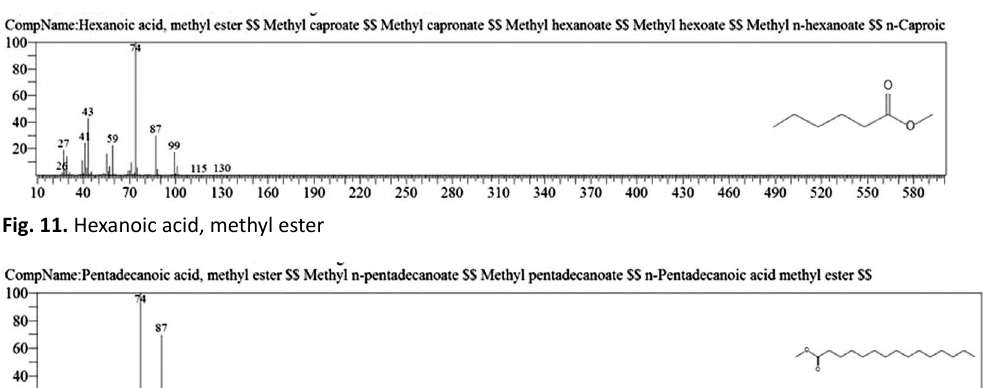
Fig. 12. Pentadecanoic acid, methyl ester